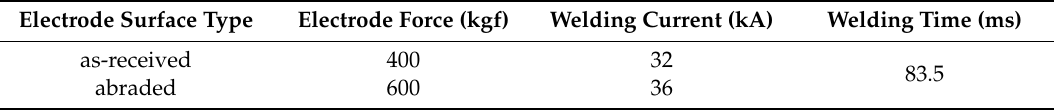
Table 2. Welding conditions used in this study.